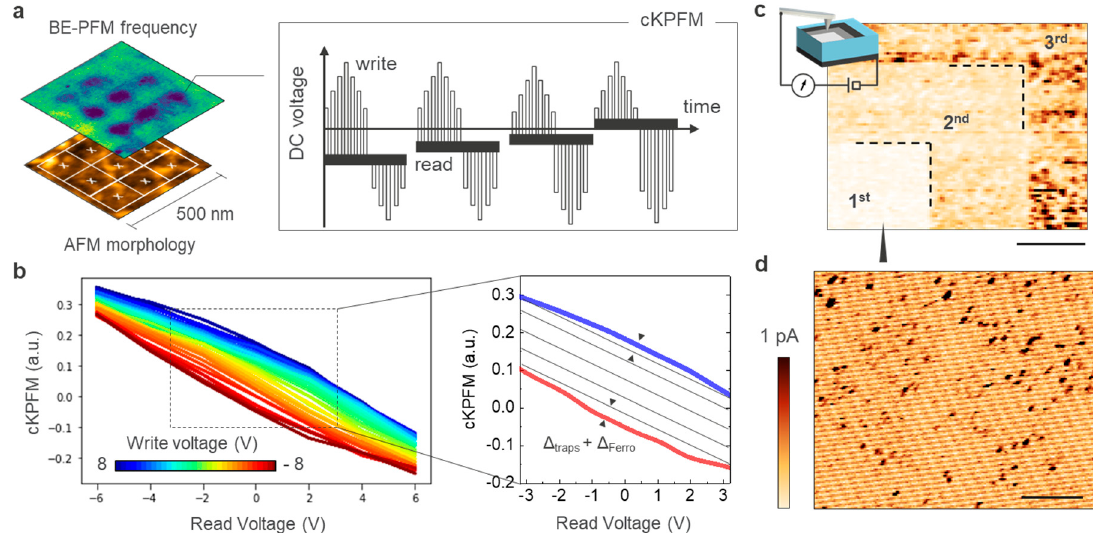
Figure 3. Contact Kelvin probe force microscopy analysis. ( a ) Schematic of the cKPFM spectroscopic array of points with associated pulsing scheme. ( b ) cKPFM results on the 8-nm thick FE-HfO 2 surface, the inset is a magnification showing the − 8 and + 8 writing conditions with linear trendlines. ( c ) C-AFM current map acquired after three scans at increasingly large scan area with constant bias 20 mV (scale bar 1.3 µ m). ( d ) C-AFM current map of the first region as measured on the first scan (scale bar 150 nm).